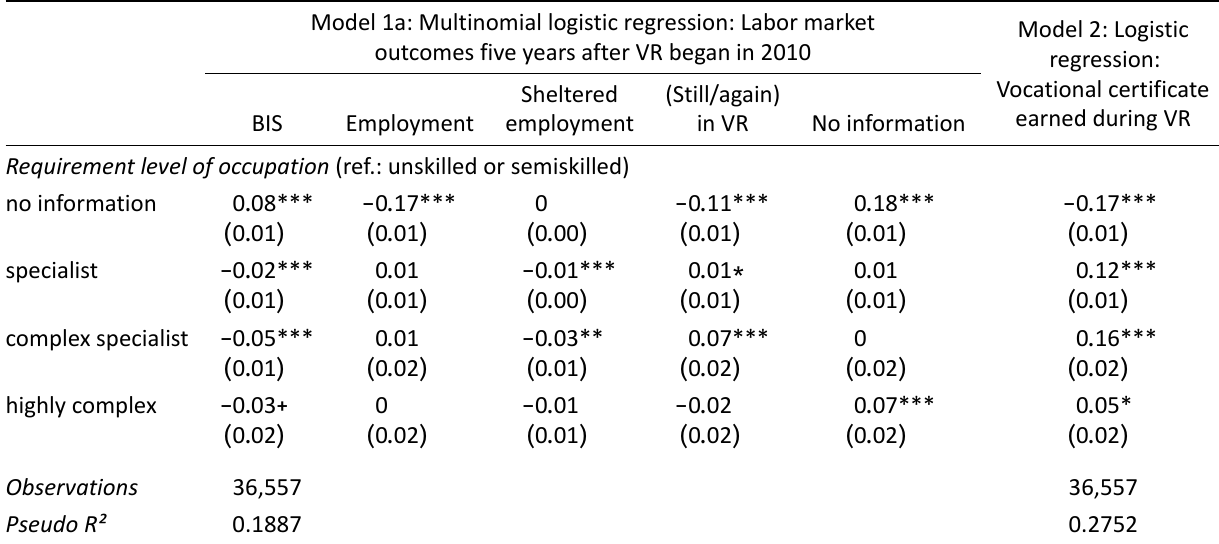
Table 2. (Cont.) Results of the multivariate analyses. Model 1a: Multinomial logistic regression: Labor market Model 2: